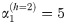
Accessibility in a toy network.Probabilities of transition from node 1 considering h = 2 steps for two distinct configuration of links. The first configuration considers only the red edges and the second one considers both red and blue edges. Note that, in the first configuration, the probability to reach any node at the second level is the same. In this case, α1(h=2)=5. When blue edges are included, nodes 7 and 9 tend to receive more visits than the other nodes, according to the considered probabilities. For this reason, the effective number of accessed nodes drops to α1(h=2)=4.71.